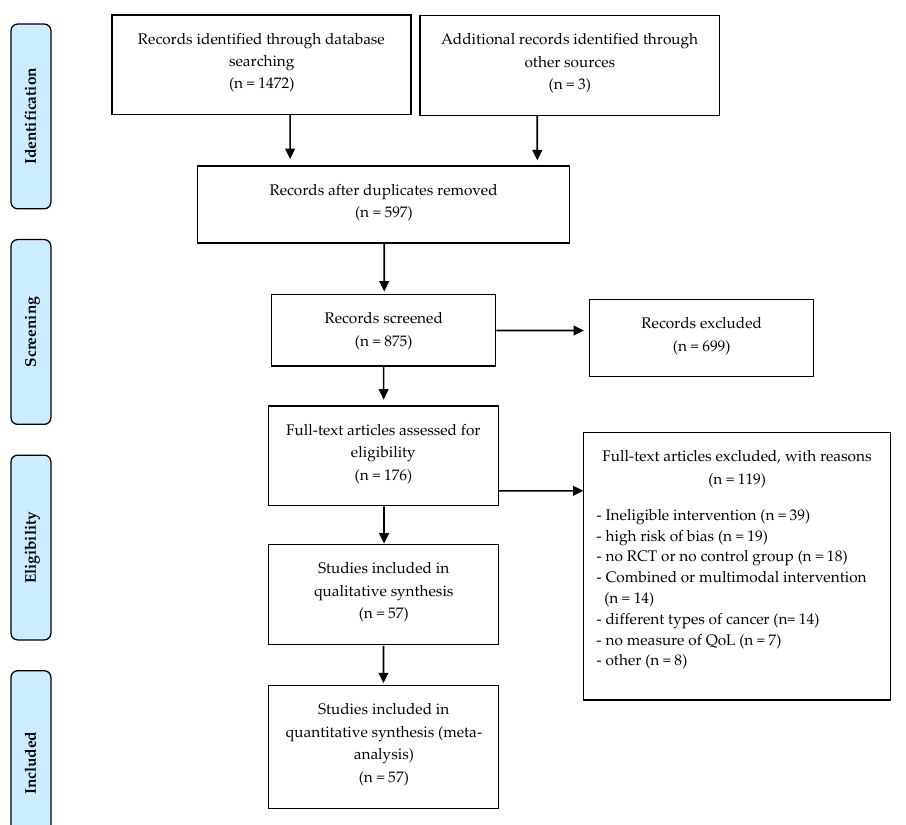
Figure 1. PRISMA flowchart of studies through the review.